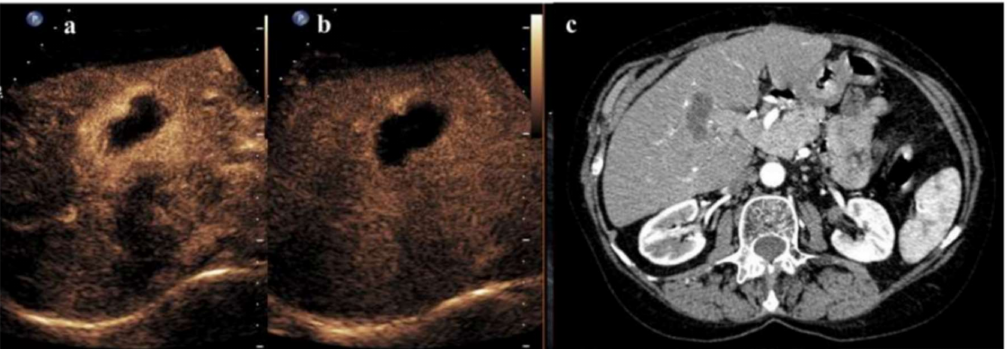
Figure 2. A 2.2 cm solitary HCC in segment IV with complete response after RFA. ( a ) Arterial phase CEUS (8 s after SonoVue injection) shows an avascular pattern with peripheral rim enhancement. ( b ) Late-phase CEUS (141 s after SonoVue injection) confirms an avascular pattern with persistent peripheral rim enhancement, suggesting reactive hyperemia. ( c ) Arterial phase CECT 1 month after RFA confirms complete